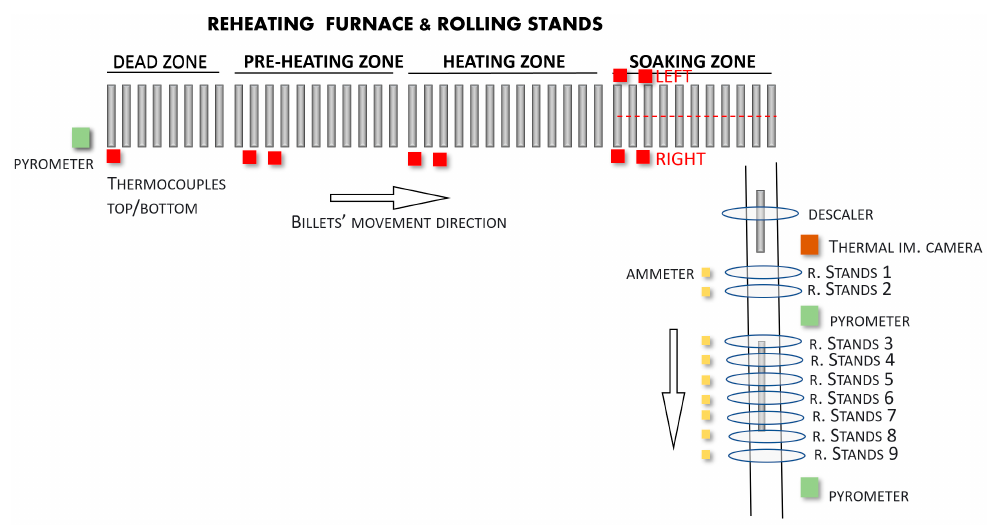
Figure 4. Modified configuration of the plant.